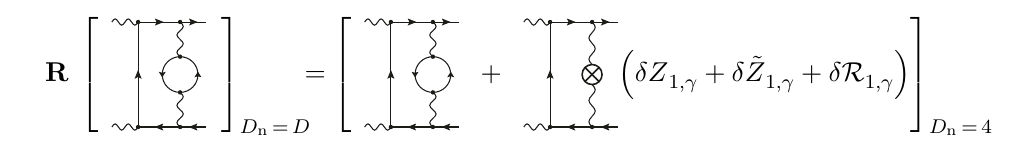
Figure 6 . Graphical representation of the master formula (5.23), see also (1.5), for a two-loop QED diagram where X ((cid:0)) < 0 and thus (cid:14)Z